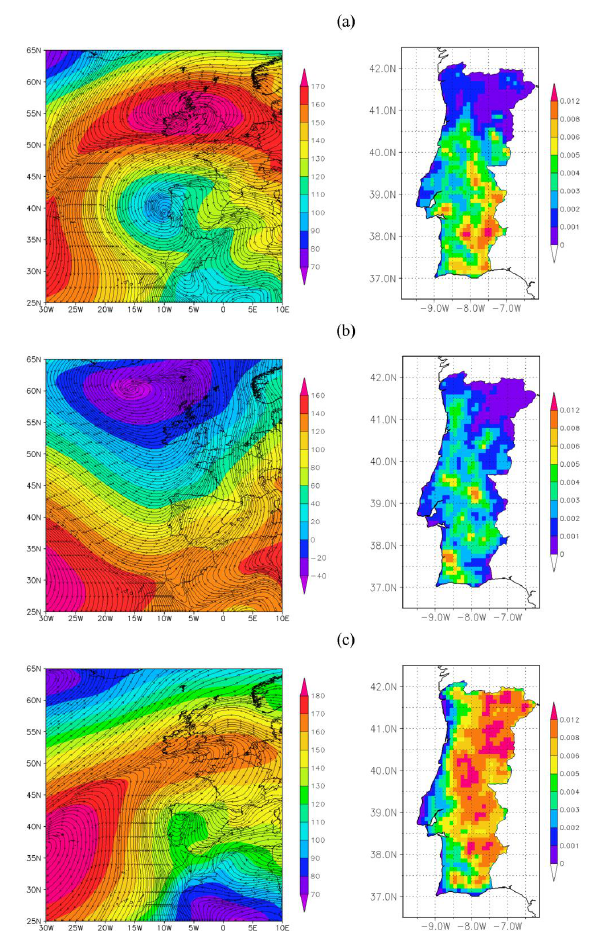
Figure 10. Composite patterns of the three AEDCGD regimes over Portugal in 2003- 693 Fig. 10. Composite patterns of the three CGD regimes over Portu- gal in 2003–2009: (a) WREG; (b) WREM; (c) SREG in the JRA 2009: (a) WREG; (b) WREM; (c) SREG in the JRA 1000 hPa geopotential height and 694 1000hPa geopotential height and streamlines of the JRA 10m hori- zontal wind (left panels; shading in hPa) and in the KS CGD density streamlines of the JRA 10 m horizontal wind ( left panels ; shading in hPa) and in the KS 695 (right panels; in discharges km − 2 .day − 1 ) . AEDCGD density ( right panels ; in discharges km -2 .day -1 ). 696